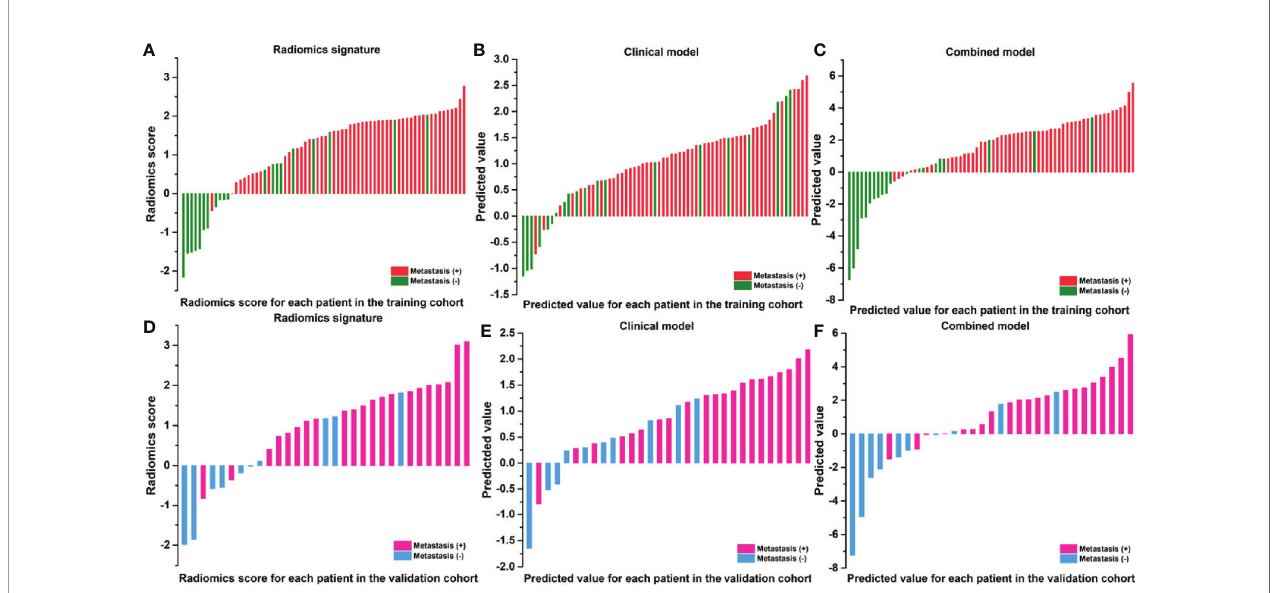
FIGURE 4 | Radiomic score for each patient in the training and validation cohorts of radiomic signature (A, D) ; of clinical model (B, E) ; of combined model (C, F)